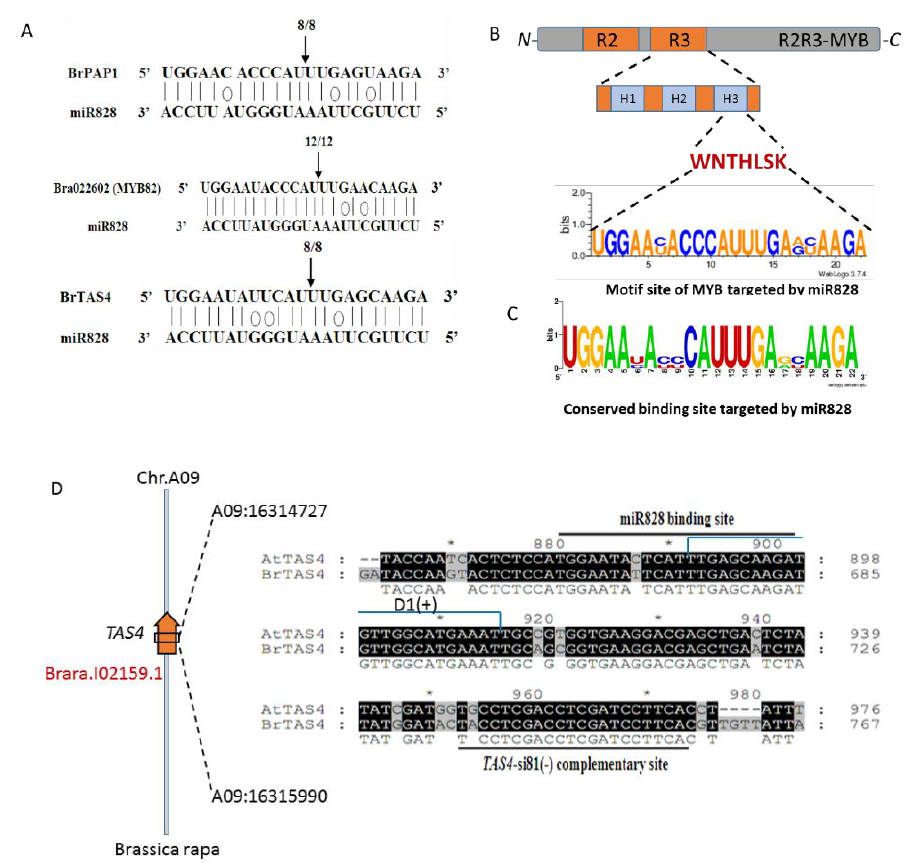
Figure 6. Sites of BrmiR828-mediated cleavage on target BrPAP1 (Bra039763), BrMYB82 (Bra022602) mRNAs and BrTAS4 and chromosome location and sequence alignment of TAS4 orthologs in Brassica rapa and Arabidopsis thaliana . ( A ) Positions of dominant 5′-RACE products of BrPAP1 , BrMYB82, and BrTAS4 are indicated by a vertical arrow in the binding region. ( B ) Schematic diagram of the motif site of BrMYB targeted by BrmiR828, H1-3 are helices. ( C ) RLM 5′-RACE verified conserved binding site targeted by BrmiR828. ( D ) The sequences designated by dark line shows the binding site of miR828 and the complementary site of TAS4-siR81(−) [46] . The first siRNA, TAS4 D1(+) originated from the splicing site of BrmiR828 and TAS4.